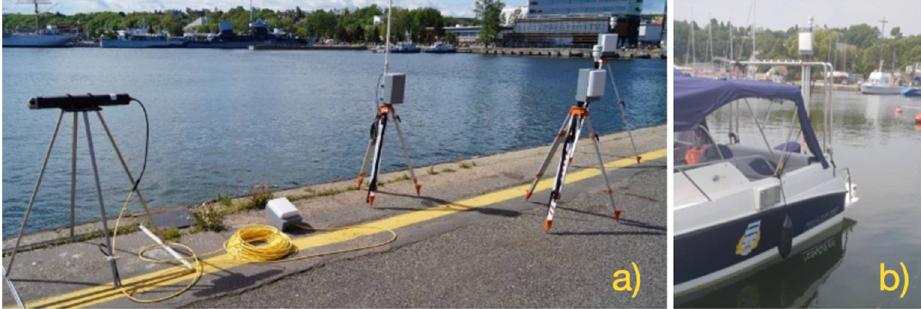
Figure 2. Weather data recording system: ( a )—during static test, ( b )—before dynamic test.